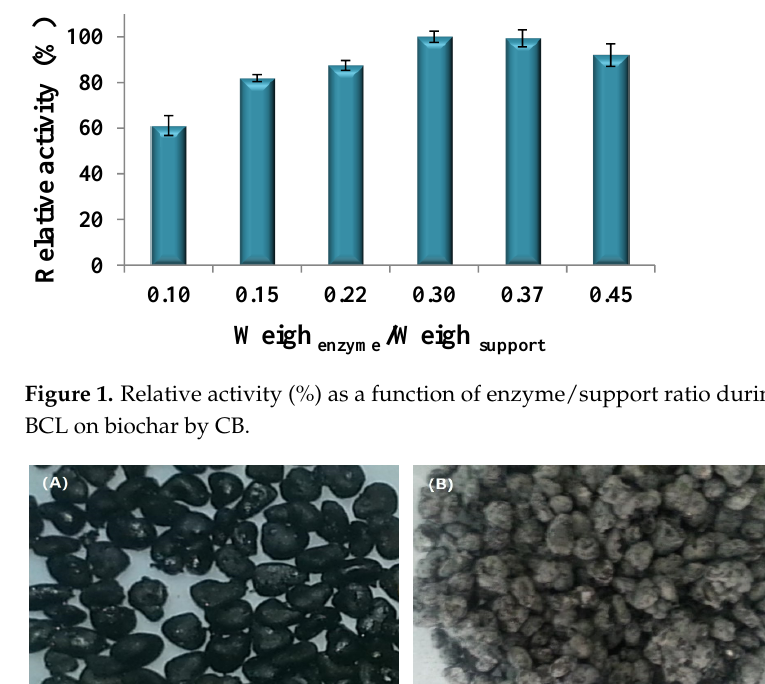
Figure 2. Macroscopic images show ( A ) Biochar surface after BCL immobilization by physical adsorption and ( B ) covalent binding. Image obtained using a 48 megapixels digital camera.